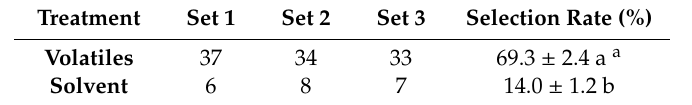
Table 1. Behavioral responses of Kaburagia rhusicola to R. potaninii volatiles or the control solvent dichloromethane in three experiments with 50 insects in each experiment after 15 min of